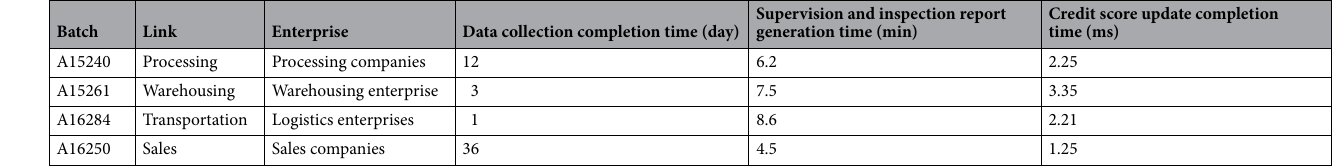
Table 5. Dynamic supervision